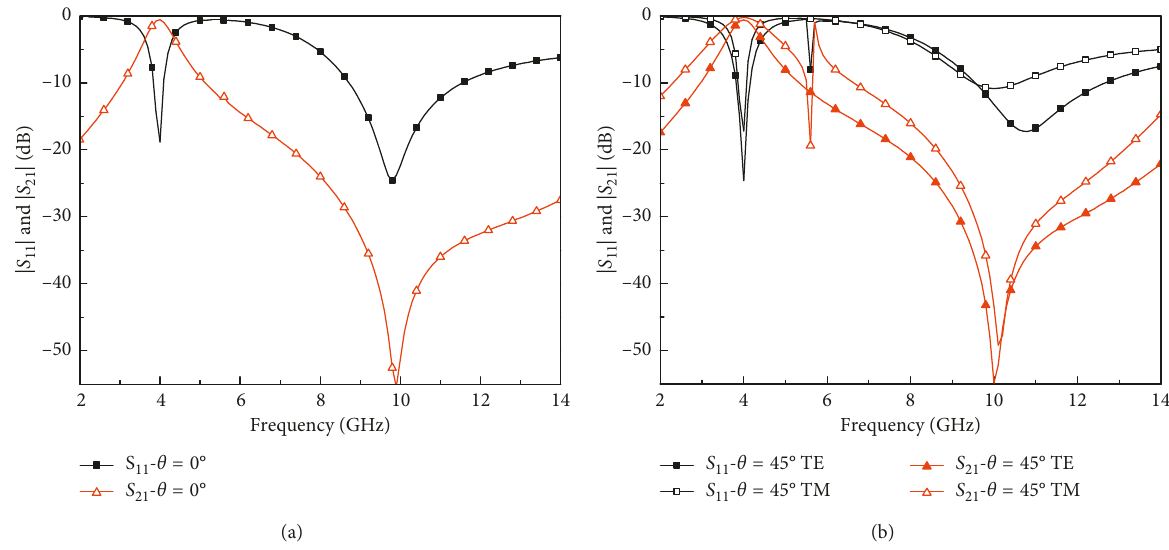
Figure 11: Simulated | S | and | S | of the FSS with optimal parameters fine-tuned by HFSS simulations. (a) Normal incidence. (b) Oblique 11 21 incidence at θ � 45 ° for TE/TM polarization.